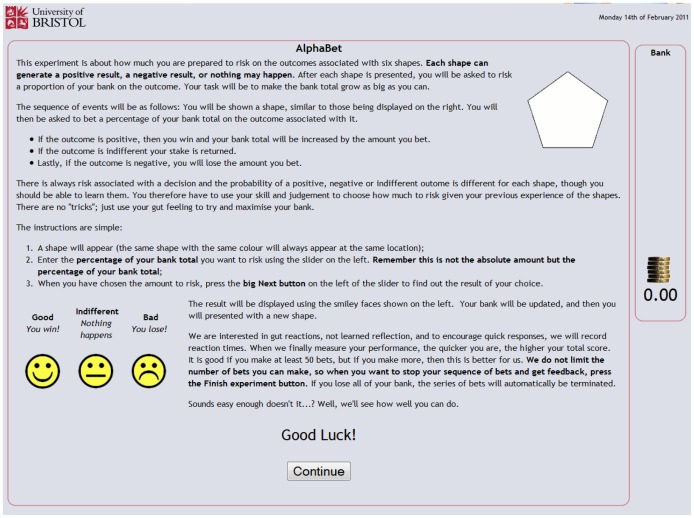
Instructions page.